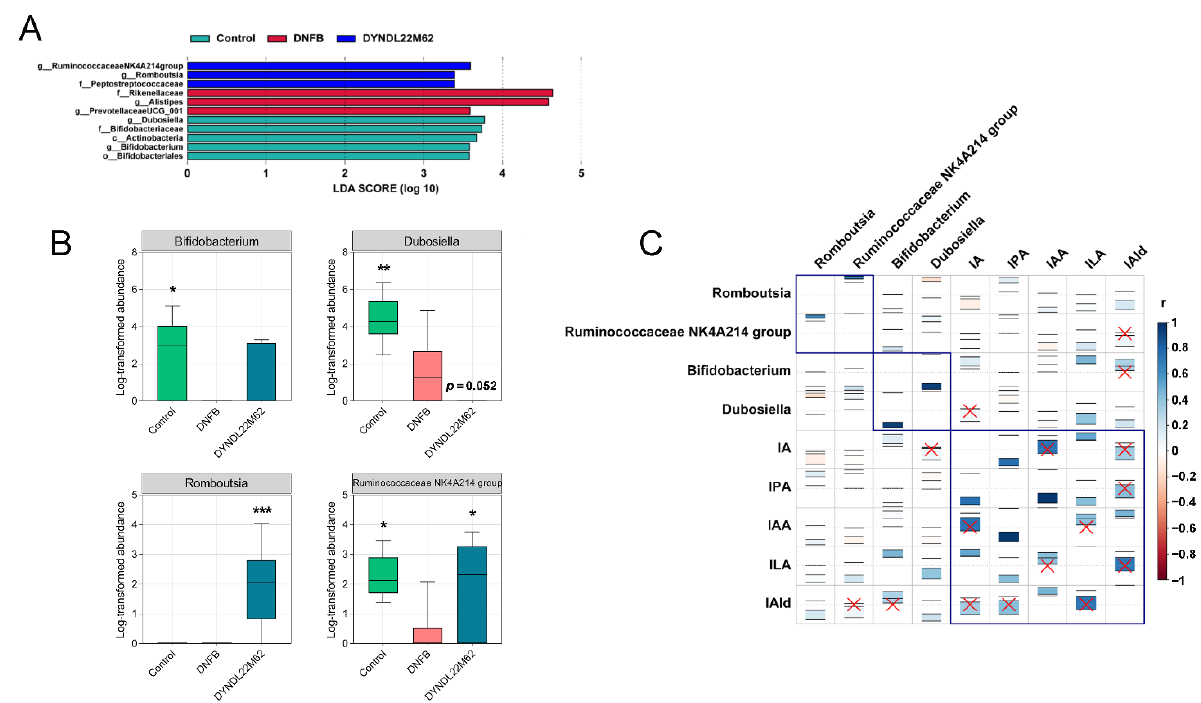
Figure 5. Differential gut bacteria and the correlation with indole derivatives. ( A ) Differential bacteria between groups using LEfSe analysis. ( B ) Comparison of differential bacteria. ( C ) The correlation between differential bacteria and indole derivatives (95% confidence interval, red cross, no significance). * p < 0.05, ** p < 0.01, *** p < 0.001 vs. DNFB group. LEfSe, linear discriminant analysis (LDA) effect size.